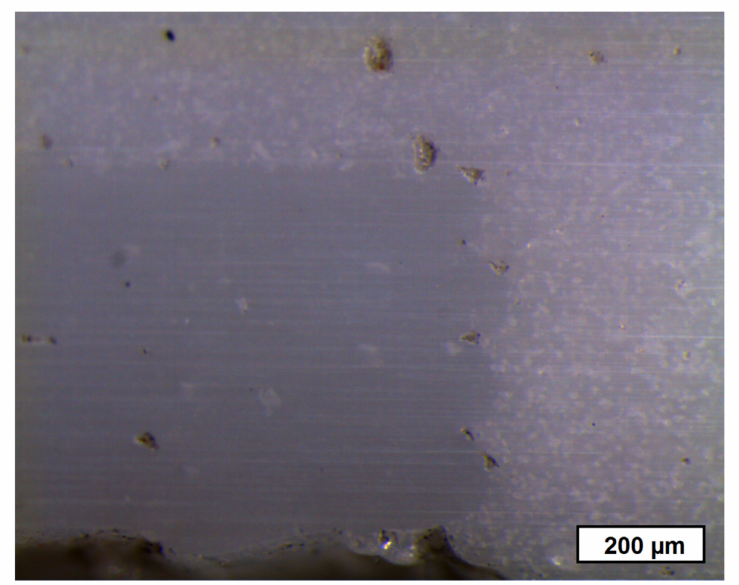
Figure 23. Light microscope image of the interface between the dense (lower left) and porous (top and right) areas within the